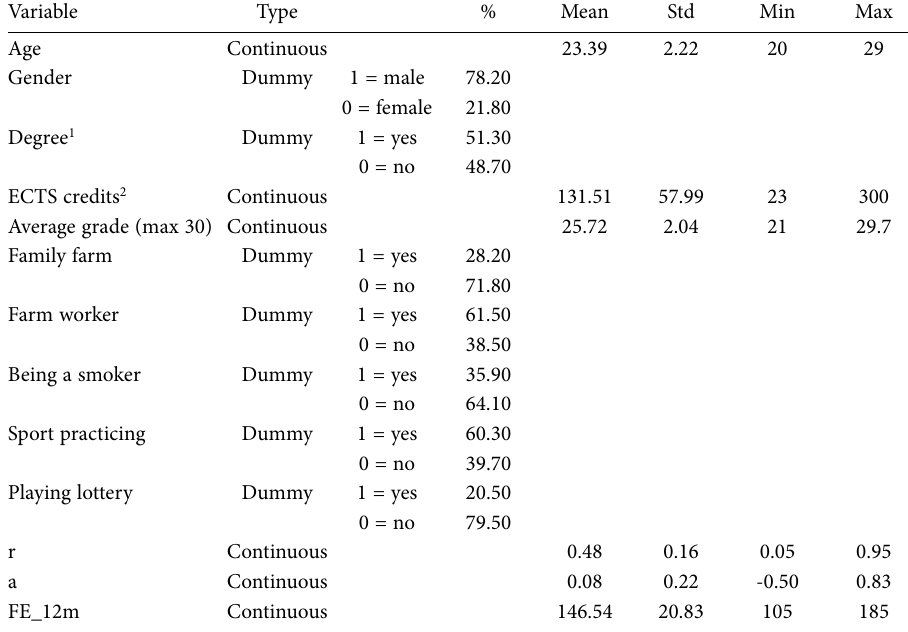
Table 1. Descriptive statistics of the sample (N = 78).